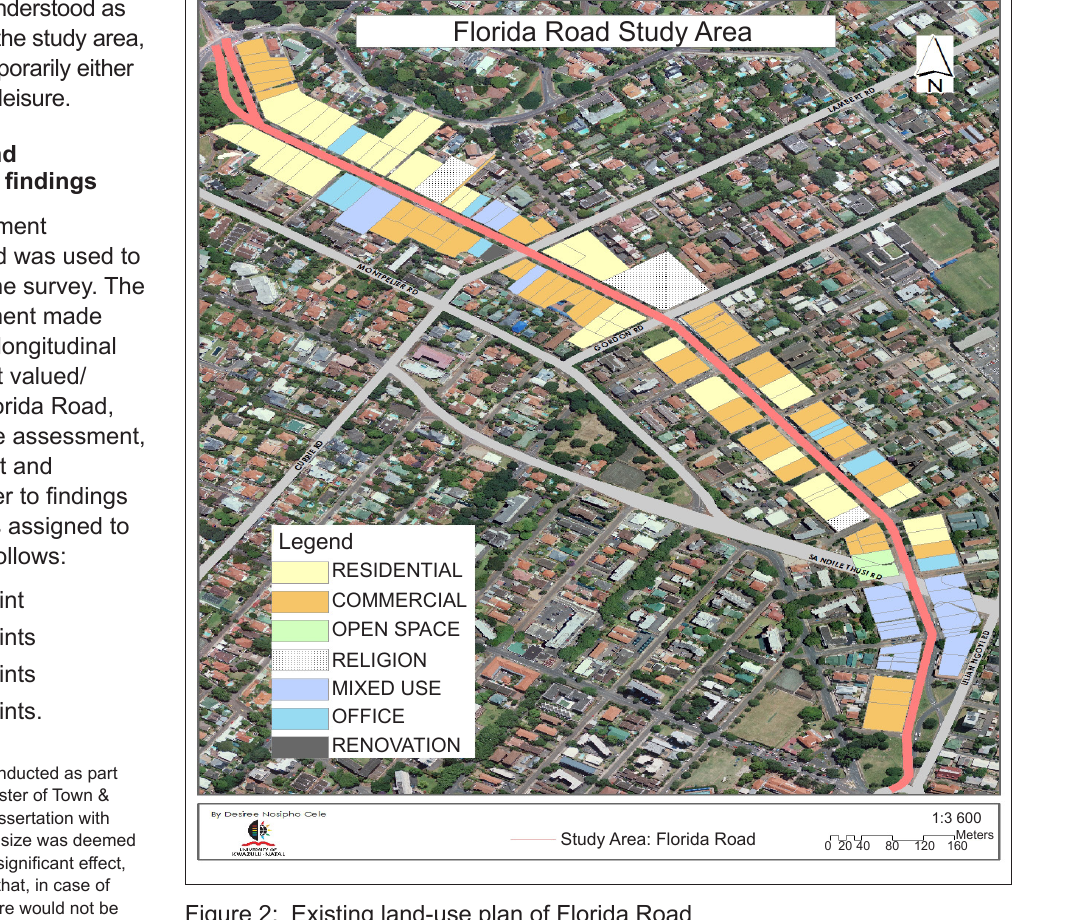
Figure 2: Existing land-use plan of Florida